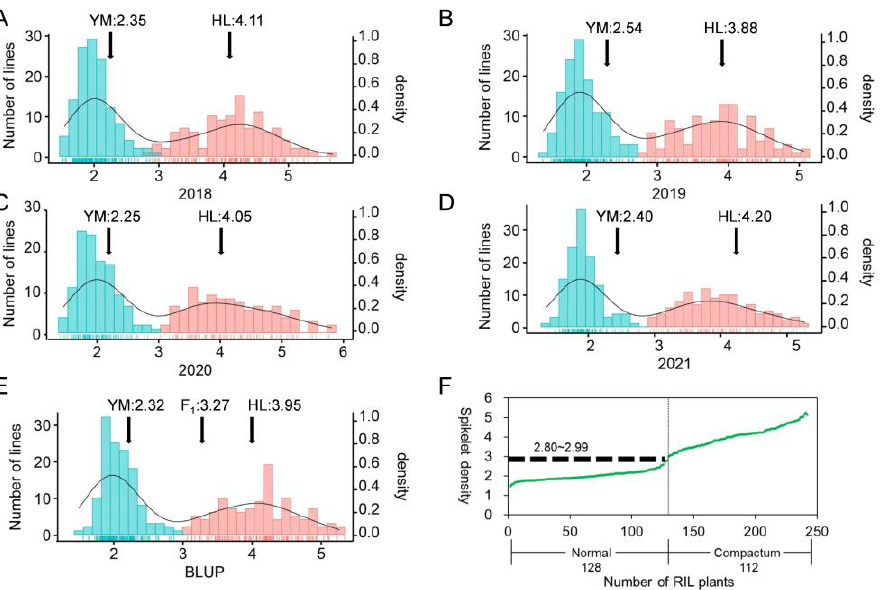
Figure 2. Spike density frequency distribution of Yangmai 158 (YM) × Triticum compactum Hiller (HL) RILs using data from each of four-year environments (( A – D ), 2018 – 2021) and BLUP values across environments ( E ) and classification of RILs according to their SD ( F ). Blue: normal spike group; red: compact spike group. Spike density was measured by the ratio of total spikelet number per spike-to-spike length.